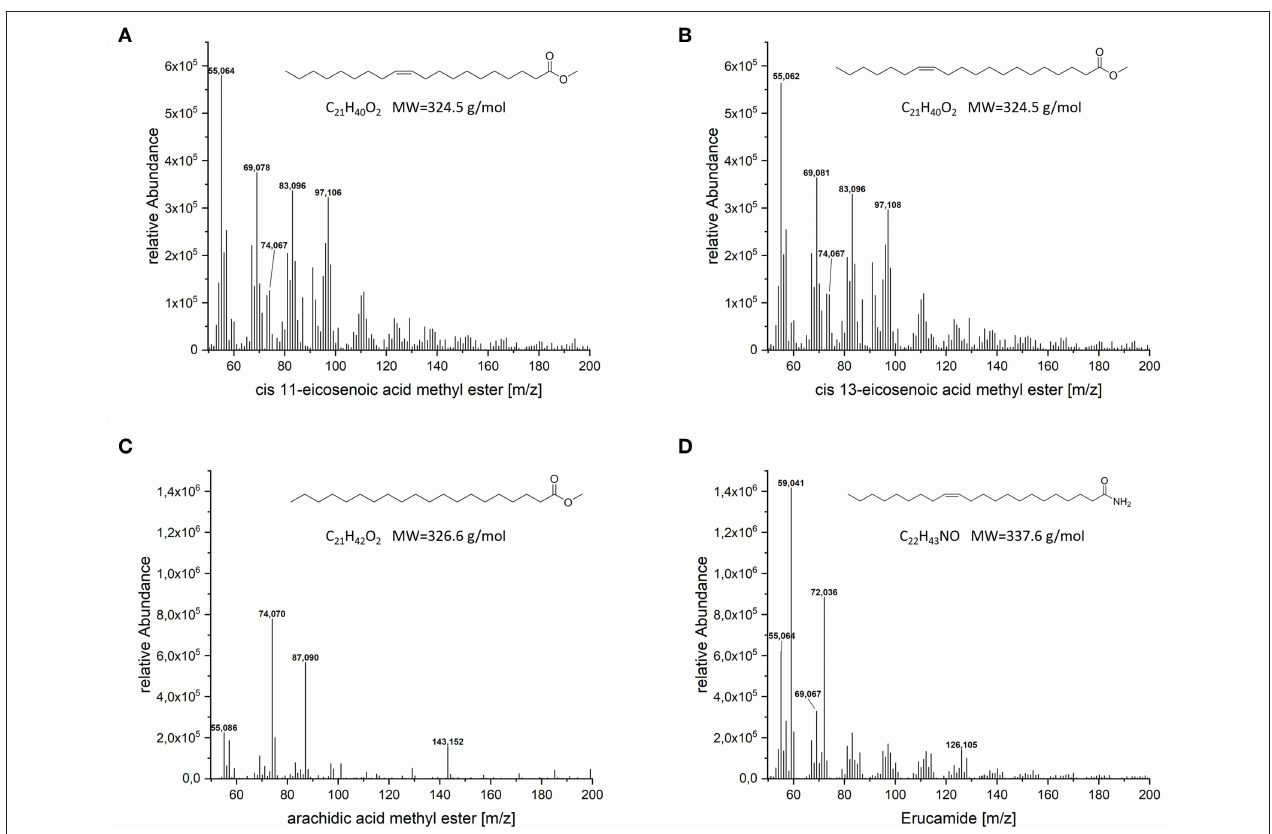
FIGURE 7 | MS spectra of the VLCFA peeks detected in GC-FID. (A) cis-11-eicosenoic acid methyl ester, (B) cis-13-eicosenoic acid methyl ester, (C) eicosanoic acid methyl ester, (D)